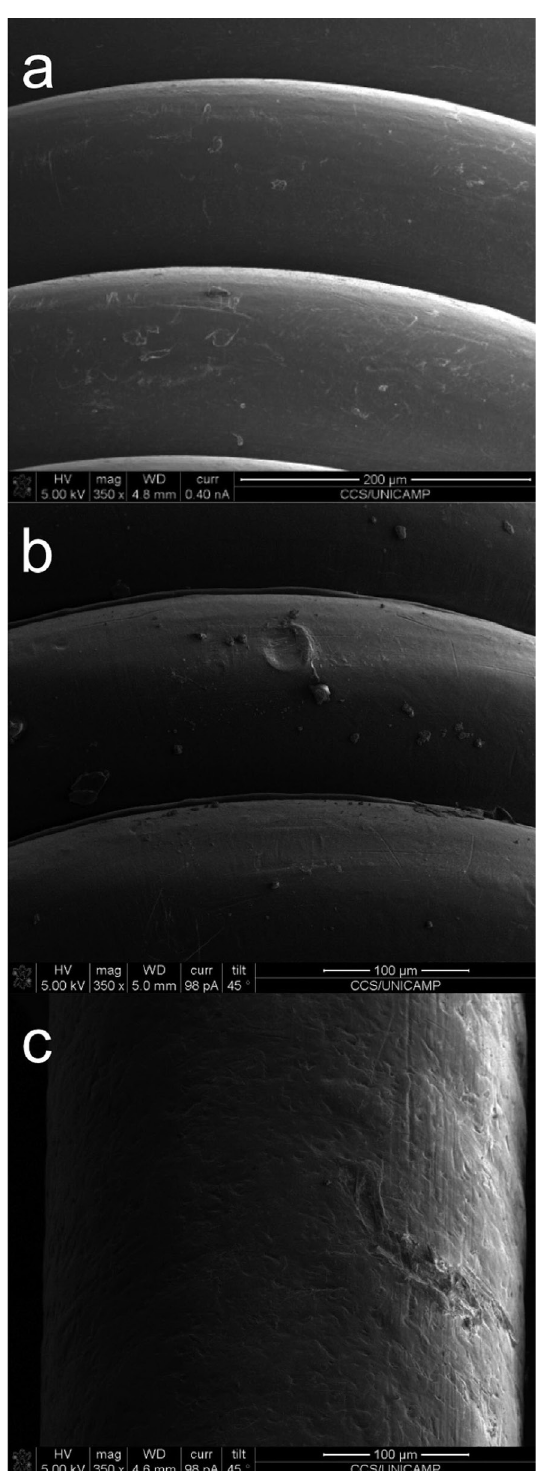
Fig. 1 – SEM pictures of guide wire catheter samples A, B and C. All surfaces with few small irregularities, considered normal for this material. Small artifacts from the manufacturing process are seen in Figure